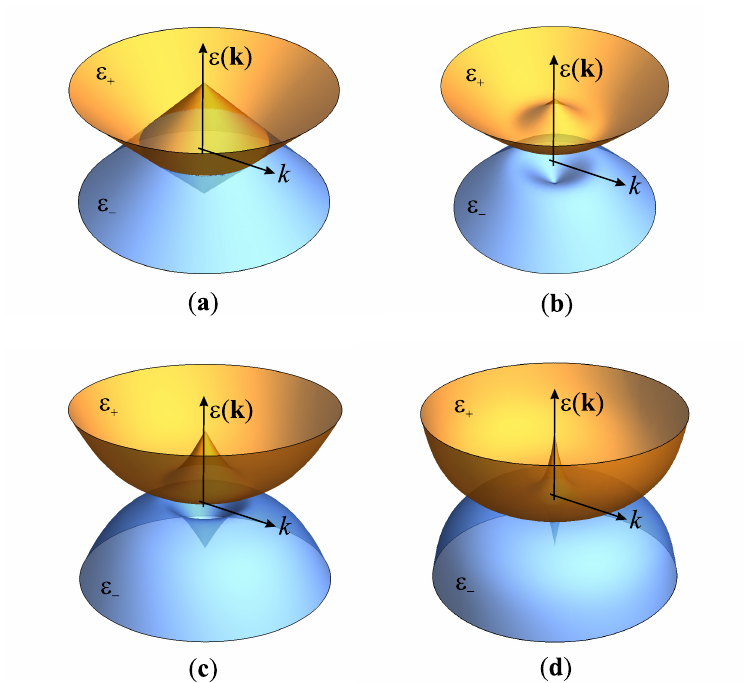
Figure 1. Schematics of the energy bands (3), conduction E + and valence E − as a function of k assuming the rotational symmetry for several choices of system parameters. The vertical distance of the cone tips, along the energy axis, is 2 δ ( δ = 1 in all four panels). The other parameters are: ( a ) n = m = 1, γ = 0 (the gap is closed); ( b ) n = m = 1, γ = 0.5; ( c ) n = m = 2, γ = 0.5; ( d ) n = 4, m = 7, γ =